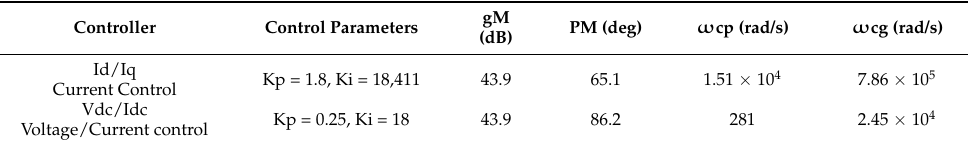
Table 2. Control parameters of the PI controllers.